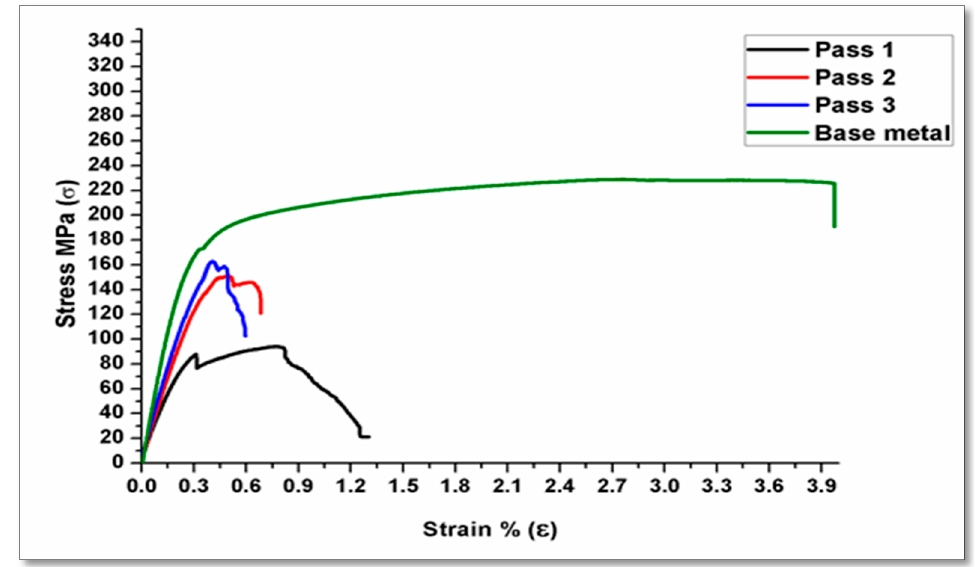
Figure 5. Effect of pass number on tensile strength at 1800 rpm with a 15 mm/min travel speed.